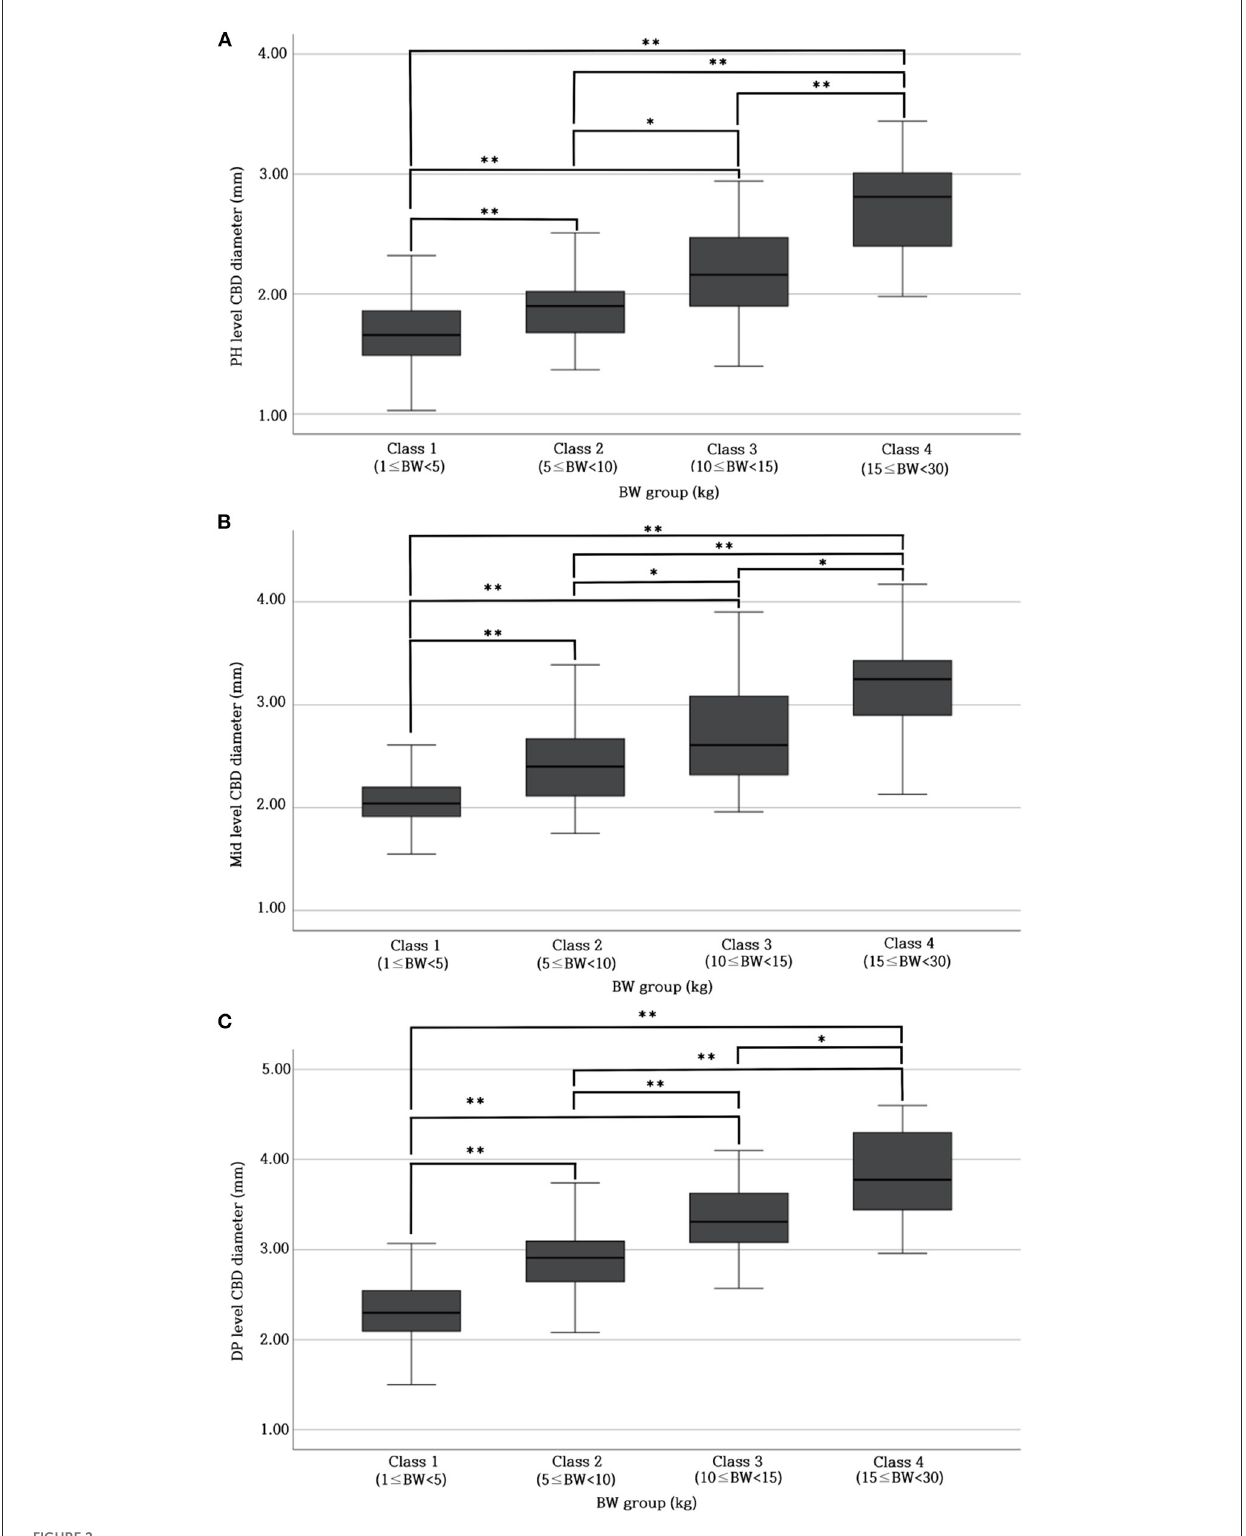
FIGURE2 Differences in CBD diameter at PH level (A) , Mid-level (B) , and DP level (C) between different BW groups. There were significant differences ( p < 0.05* or p < 0.001**) in CBD diameter at each level (PH, Mid, and DP level) among all BW groups. BW, body weight; CBD, common bile duct; DP, duodenal papilla; Mid, mid-portion; PH, porta